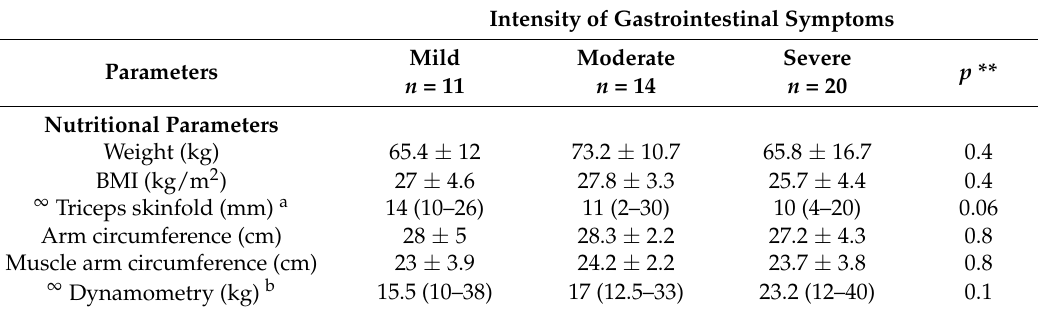
Table 3. Relationship of nutritional parameters and the severity of GIS.